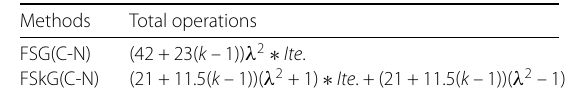
Table 3 Total number of arithmetic operations of FSG(C-N) and FSkG(C-N)